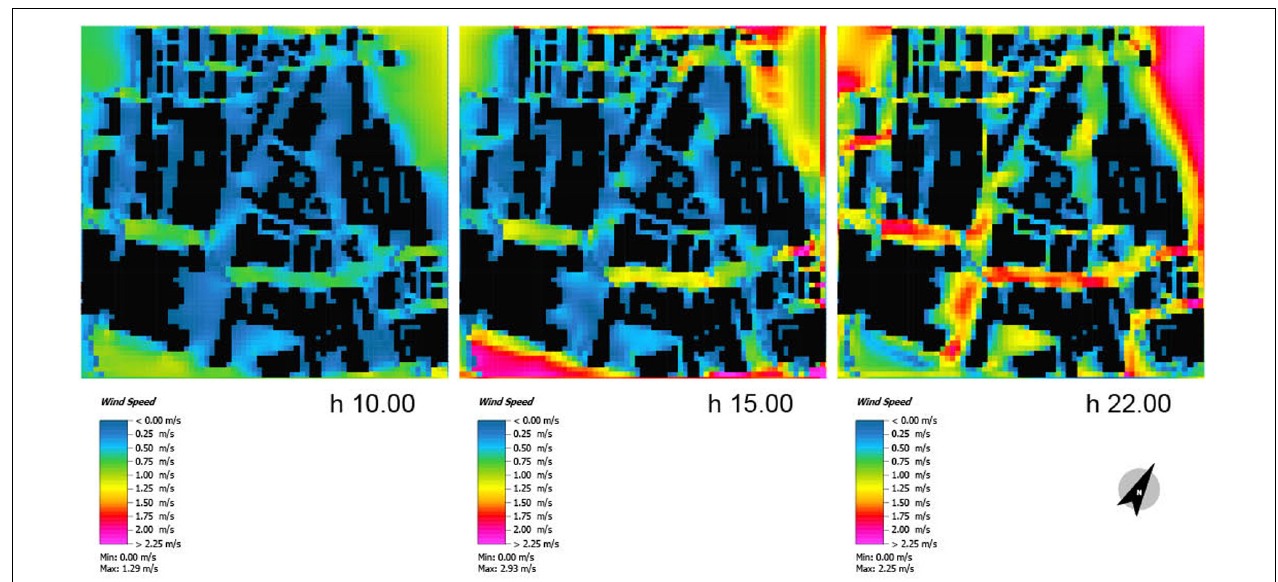
FIGURE 8 | Spatial distribution of wind speed at 2 m